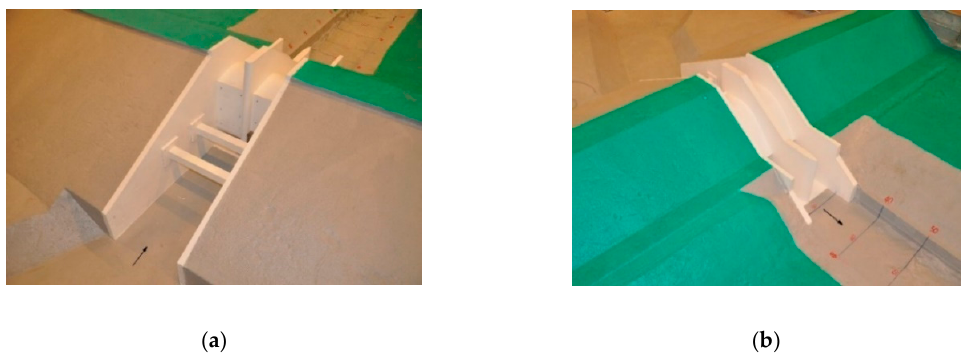
Figure 6. Spillway in the physical model (scale 1:30). ( a ) Upstream view; ( b ) downstream view.